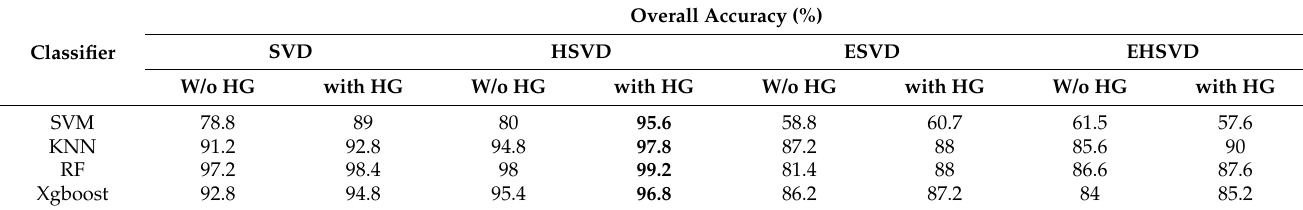
Table 3. Case Study-I: Singular Feature Performance with and Without Hyper Parameters (for Different PD Location).